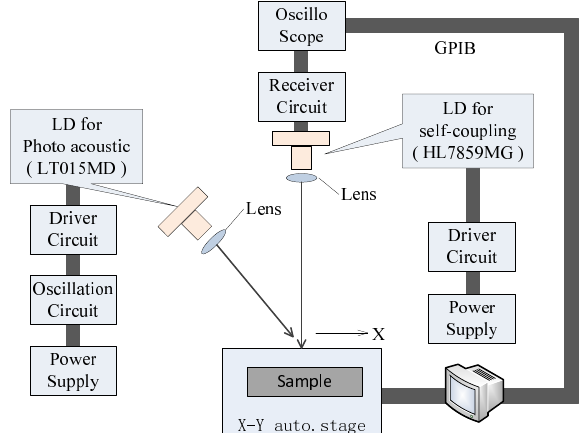
Figure 25. Schematic of the experimental setup using the photoacoustic and self-coupling effect to detect internal